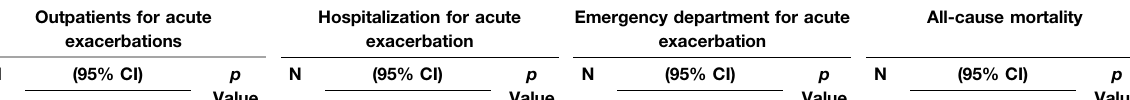
TABLE 3 | Incident rate ratio of study outcomes for matched cohorts with different types of